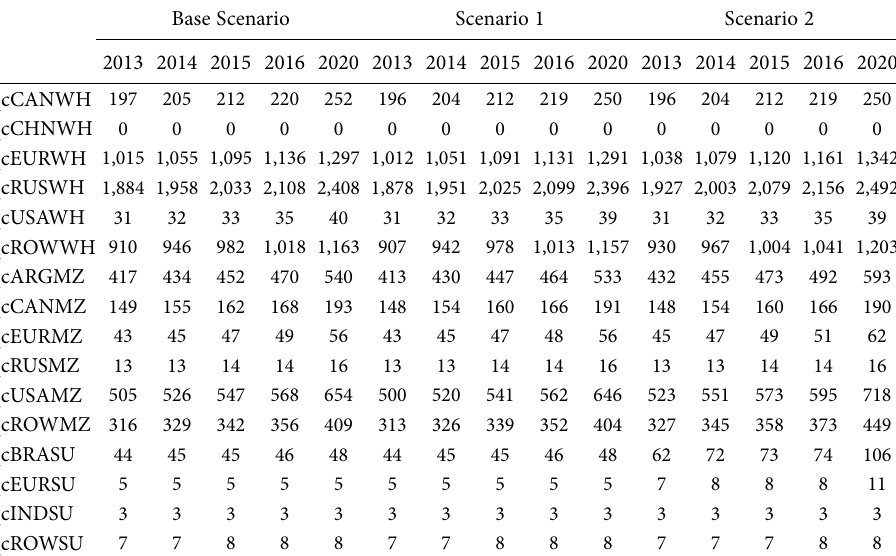
Table A.2. Bilateral imports (000 tons). Base Scenario Scenario